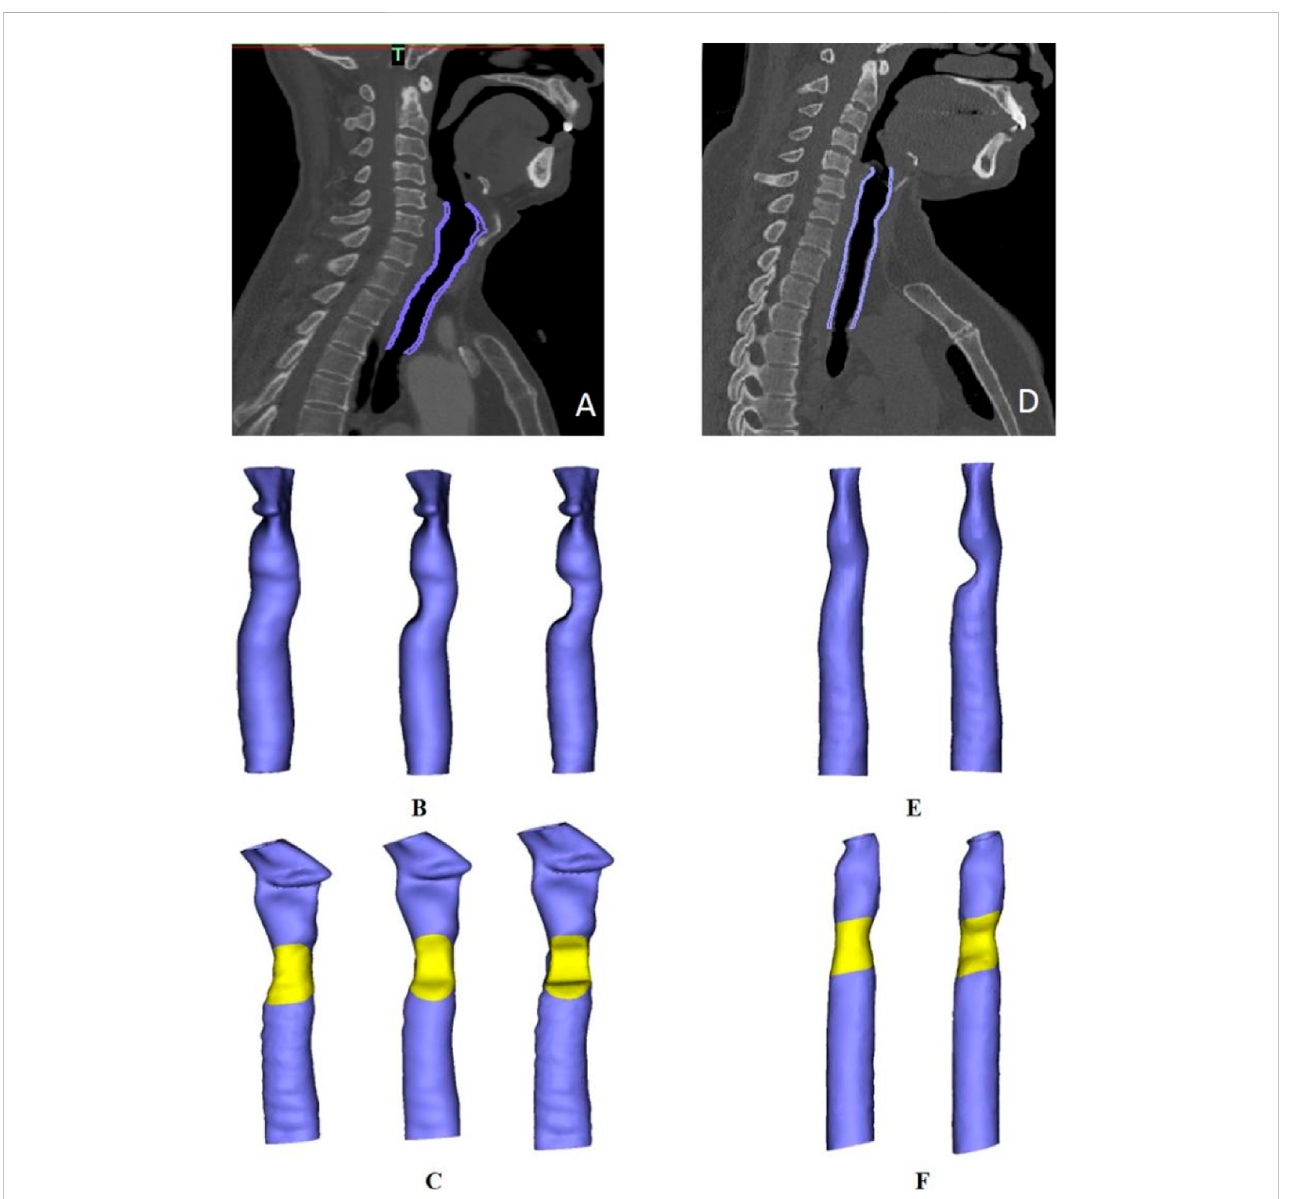
FIGURE 3 Trachea model reconstruction in two patients. (A,D) Purple areas represent the scope of the model in patients one and two, respectively. (B) . Three tracheal models for patient one with different degrees of stenosis (from left to right: normal, 33% stenosis and 50% stenosis). (C,F) Diagram of patch positioning in each patient. (E) . Models depicting a normal trachea and a trachea with 50% stenosis in patient two.